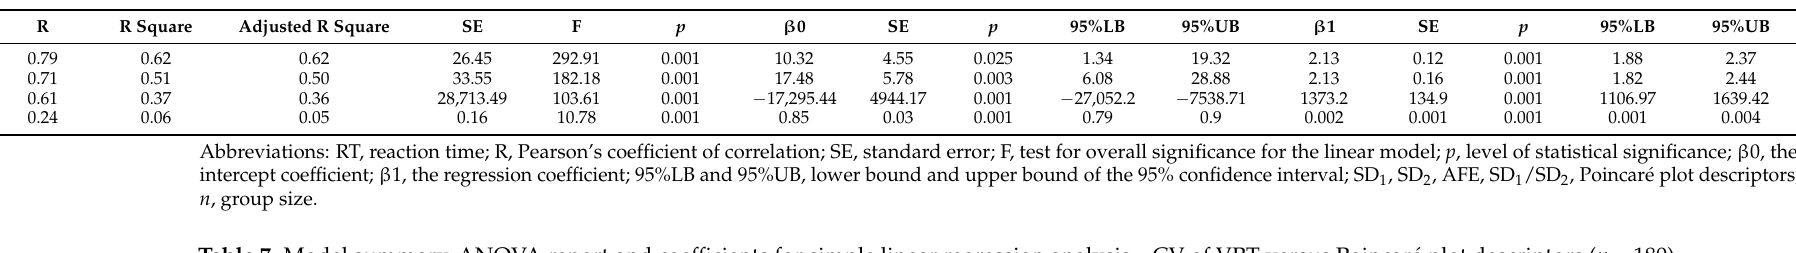
Table 7. Model summary, ANOVA report and coefficients for simple linear regression analysis—CV of VRT versus Poincar é plot descriptors ( n =